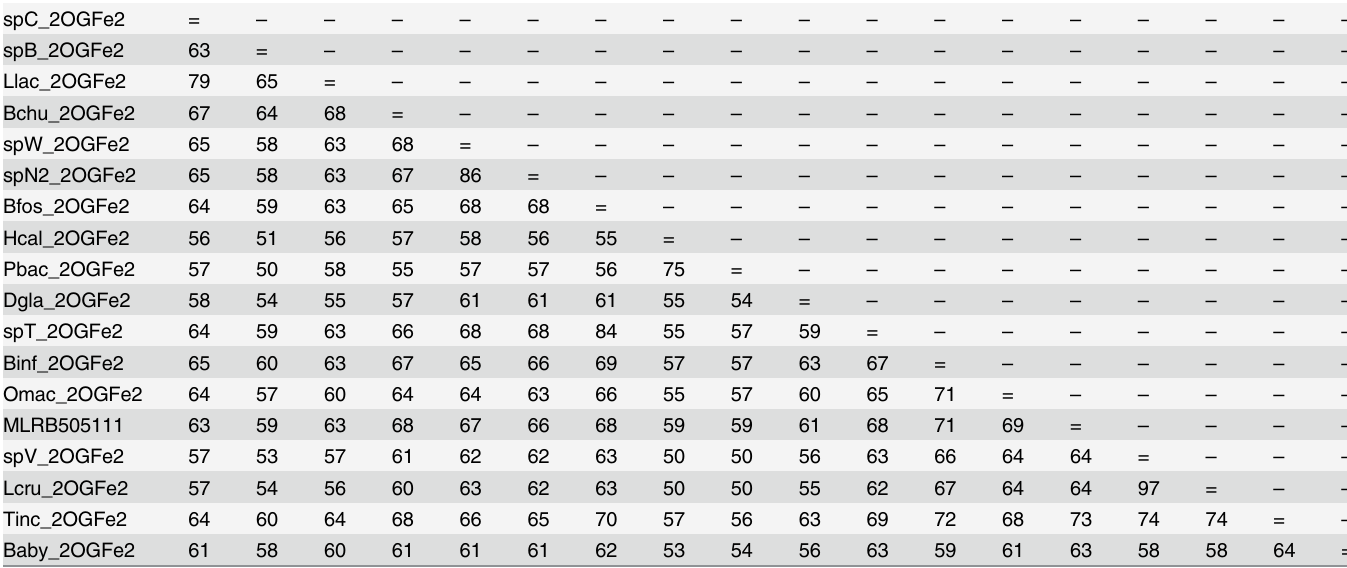
Table 7. Percent Identity Matrix of all 2-oxoglutarate Fe-Group 2